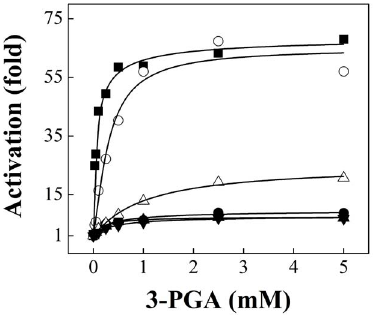
Figure 3. Saturation curves of 3-PGA for the wild type potato tuber ADP-Glc PPase ( & ) and mutants Stu S Q75A / Stu L ( N ), Stu S/ Stu L Q86A ( # ), Stu S W116A / Stu L ( m ), Stu S/ Stu L W128A ( n ), and Stu S W116A / Stu L W128A ( . ). Reactions were performed using Assay B , as stated under ‘‘Materials and